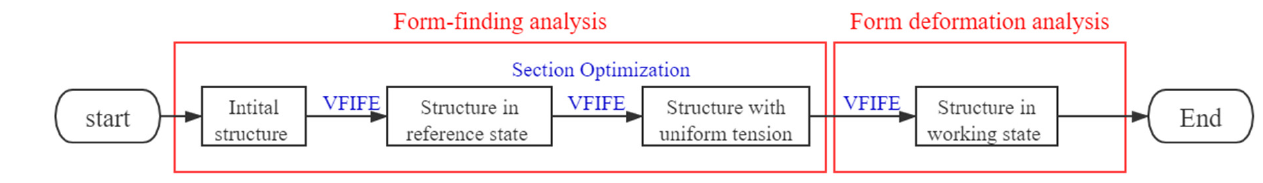
Figure 7. Calculation flow of the form analysis.